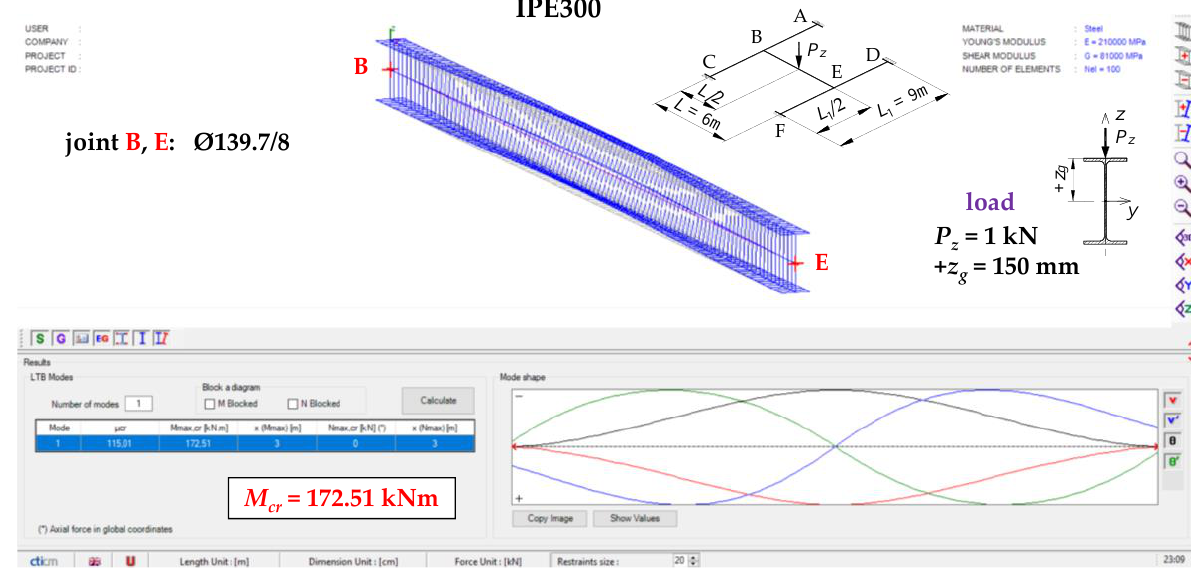
Figure 6. The ECR and the mode of lateral torsional buckling of the critical beam B – E of H-grillage (IPE300, L = 6 m, L 1 = 9 m) acc. LTBeamN.